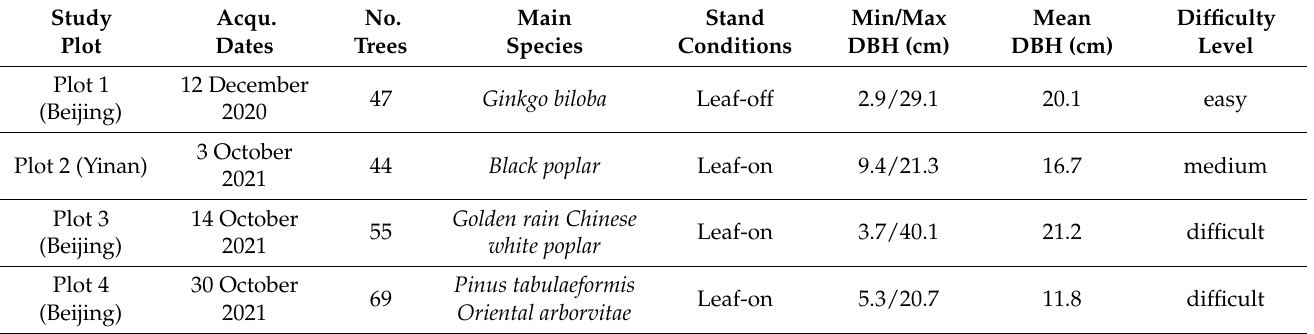
Table 1. Acquisition dates and characteristics of each